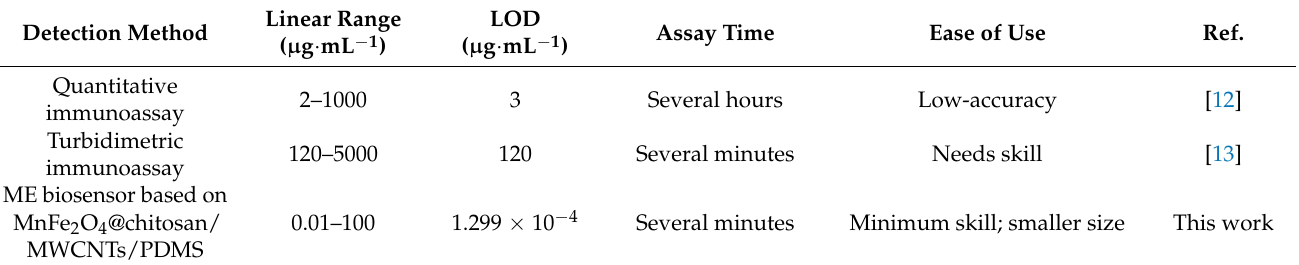
Table 1. Comparisons of performances between various methods for α 2 ‐ M detection.